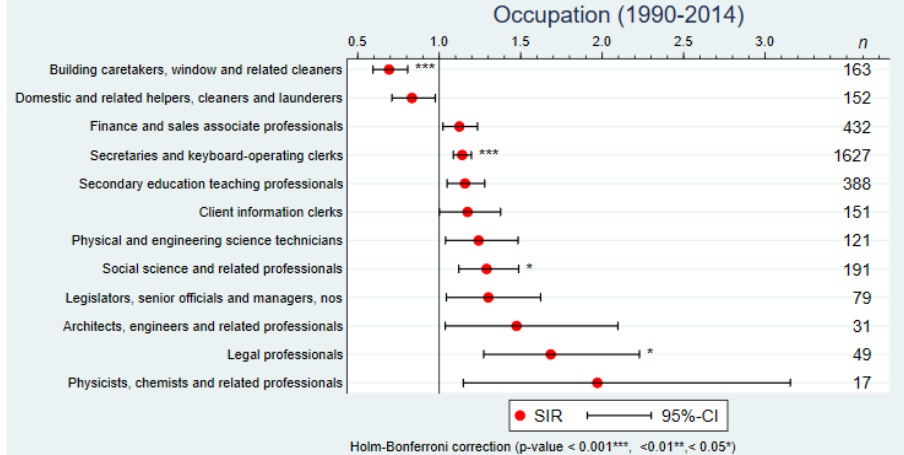
Figure 1. Standardized incidence ratios (SIR) of breast cancer by occupation (3-digits ISCO-88) in western Switzerland, 1990–2014 (only occupations with a statistically significant SIR before the Holm–Bonferroni correction are shown).